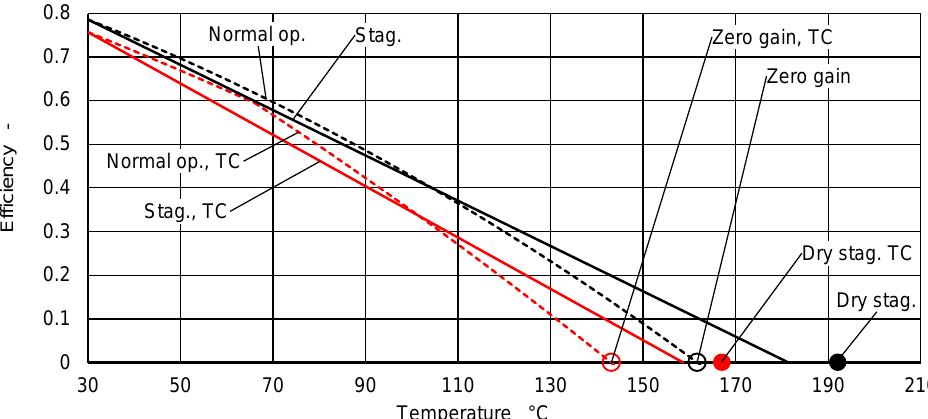
Figure 4. Collector efficiency curves for conventional selective coating (black lines) and thermochromic coating (red lines), valid for G = 1000 W/m 2 and T a = 30 ◦